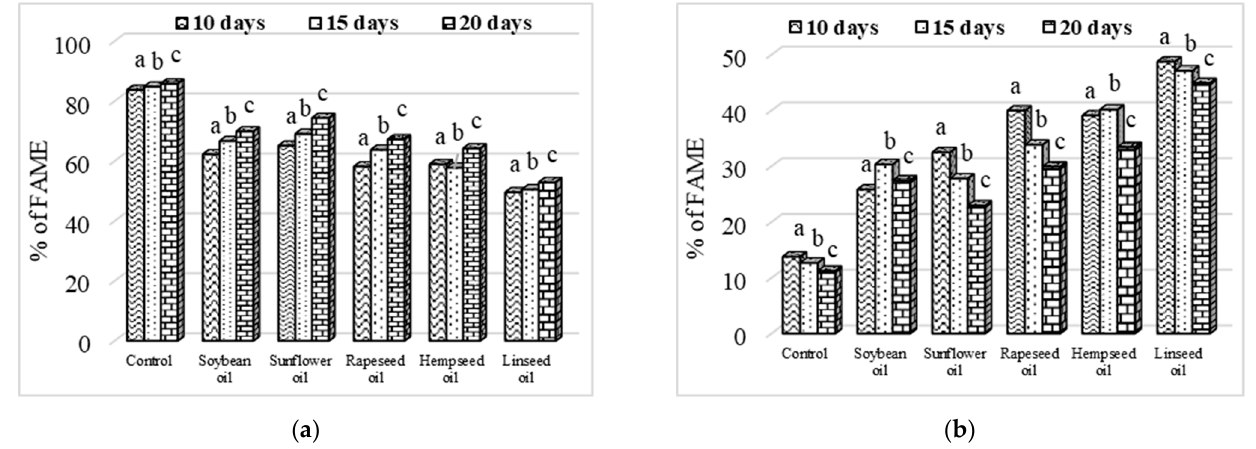
Figure 3. Evolution of saturated fatty acids ( a ) and unsaturated fatty acids ( b ) according to larvae age. Different letters (a–c) above means indicate intragroup significant differences at p < 0.05. The level of MUFAs and PUFAs decreased with the larvae age development; there- fore, at the age of 20 days, the larvae had the lowest levels of MUFAs and PUFAs (Figure 4).